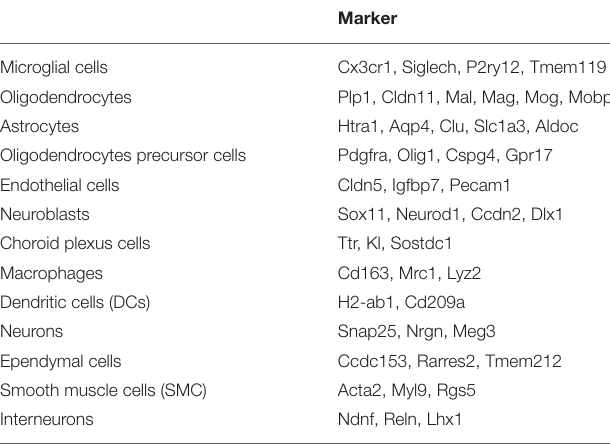
TABLE 1 | All cell types were obtained by scRNA-seq analysis and their corresponding marker.